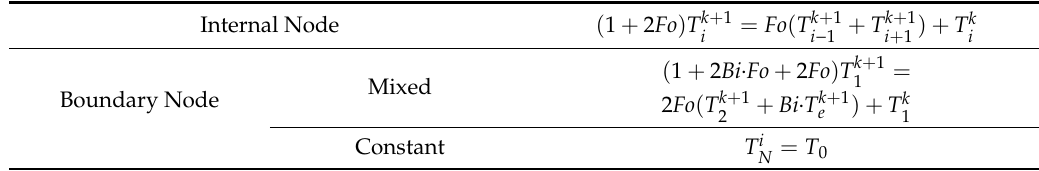
Table 3. Node di ff erential equation in the